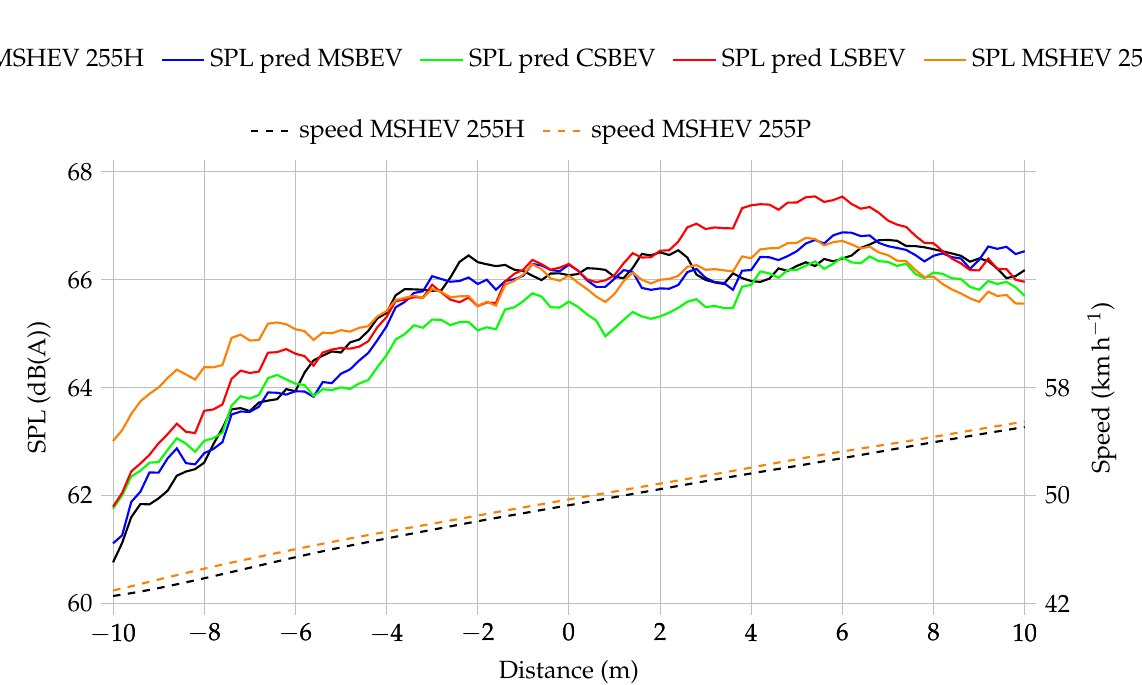
Figure 20. Tire change for MSHEV, tires measured while mounted on different EVs, pred indicating the EV used for the